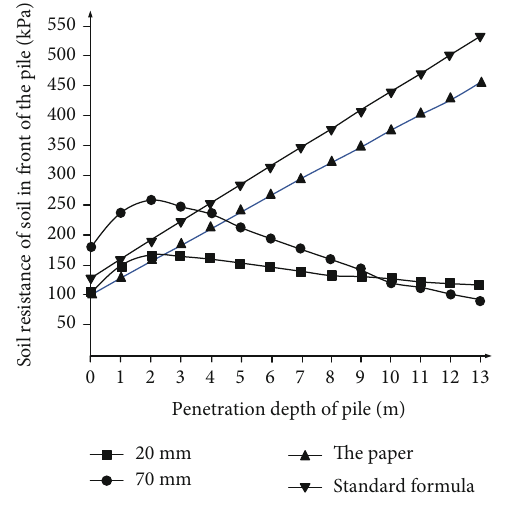
Figure 13: Comparison of theoretical and numerical